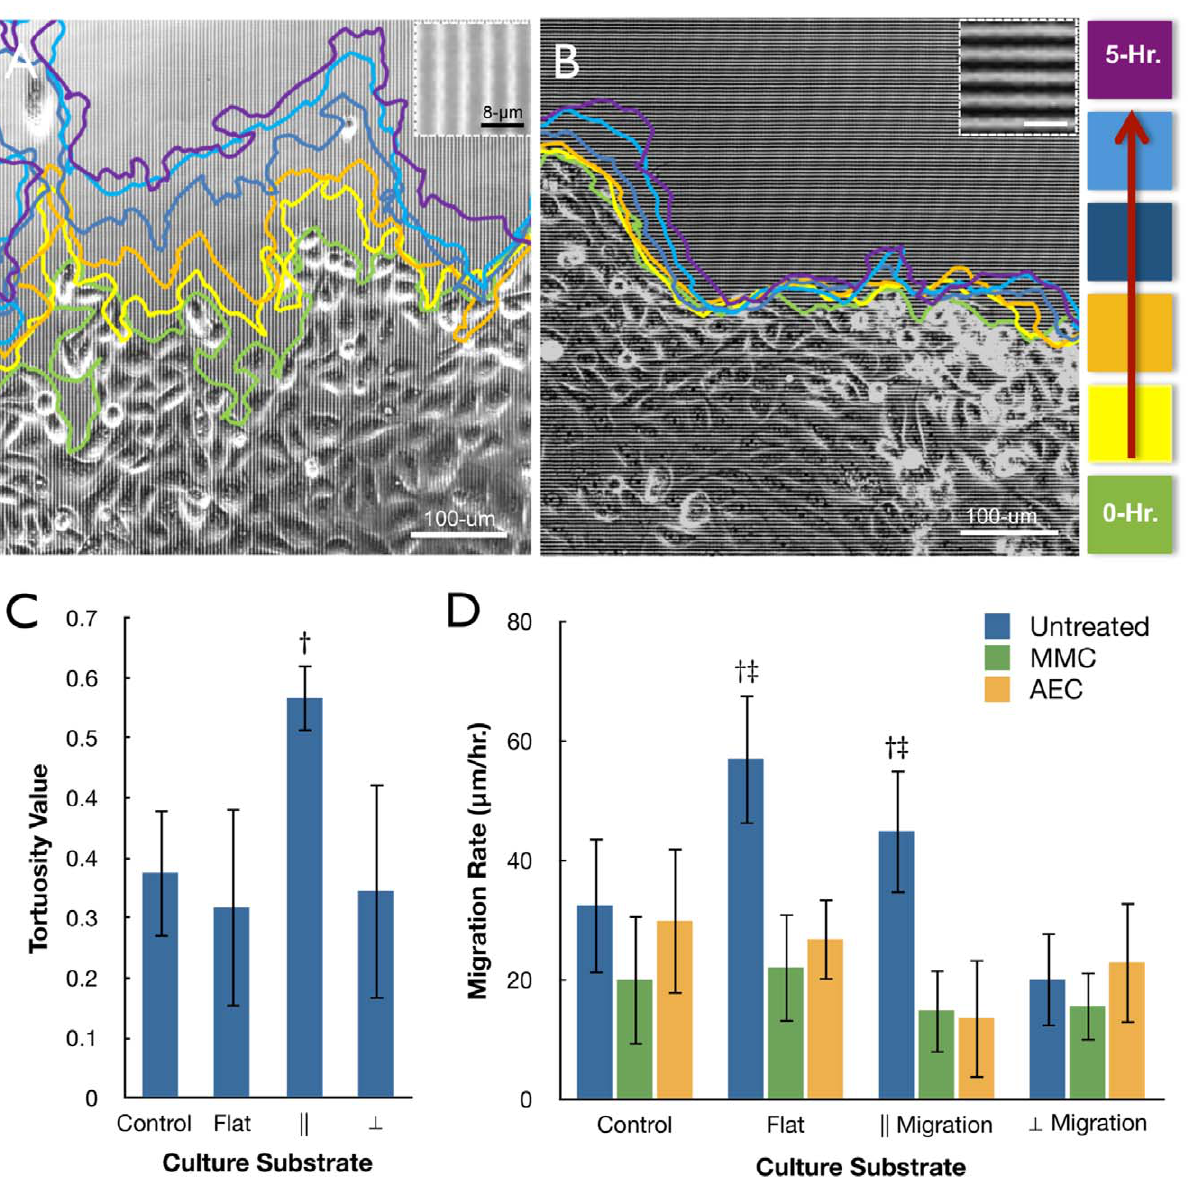
Figure 3. Cell sheet migration on silk film culture surfaces. Phase contrast images of migrating cell sheets on patterned silk films substrates traveling in the (A) parallel or (B) perpendicular direction of the feature edge as indicated by the inset images of the patterned surfaces, and color tracings are taken at 1-hour increments as indicated by the colored legend. (C) Tortuosity measurements for the migrating cell sheet border on glass controls, flat silk, and patterned silk surfaces accounting for sheet movement parallel (||) and perpendicular ( H ) to the feature edge axis respectively. (D) Cell sheet migration rate on glass controls, flat silk, and || or H directions to the patterned silk surfaces for untreated, MMC treated, and AEC treated cultures (n=4, { { indicate p , 0.05 to the patterned H direction within groups and between treatment groups respectively, error bars=SD).